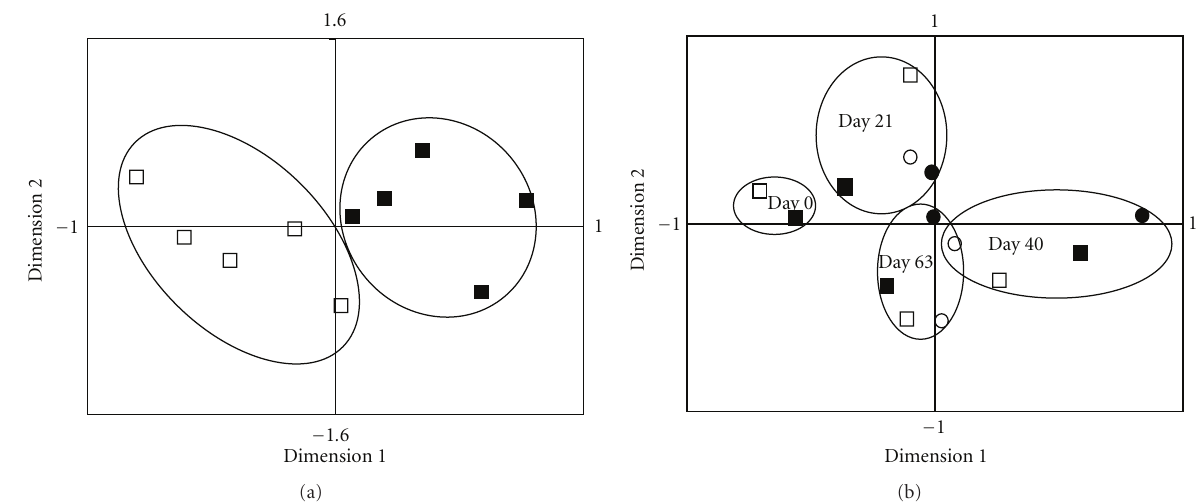
Figure 3: Ordination plots of DGGE data from pasture soils in (a) May and (b) May–September. Stress of the plot = (a) 0.15 and (b) 0.15. Symbol designations are as described in Table